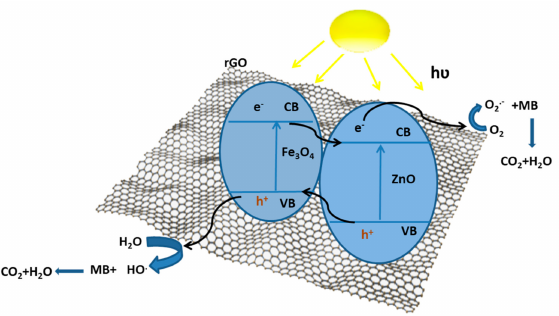
Figure 8. Schematic diagram of MB photodegradation by Fe 3 O 4 /rGO/ZnO crystalline nanocompos- ite under visible